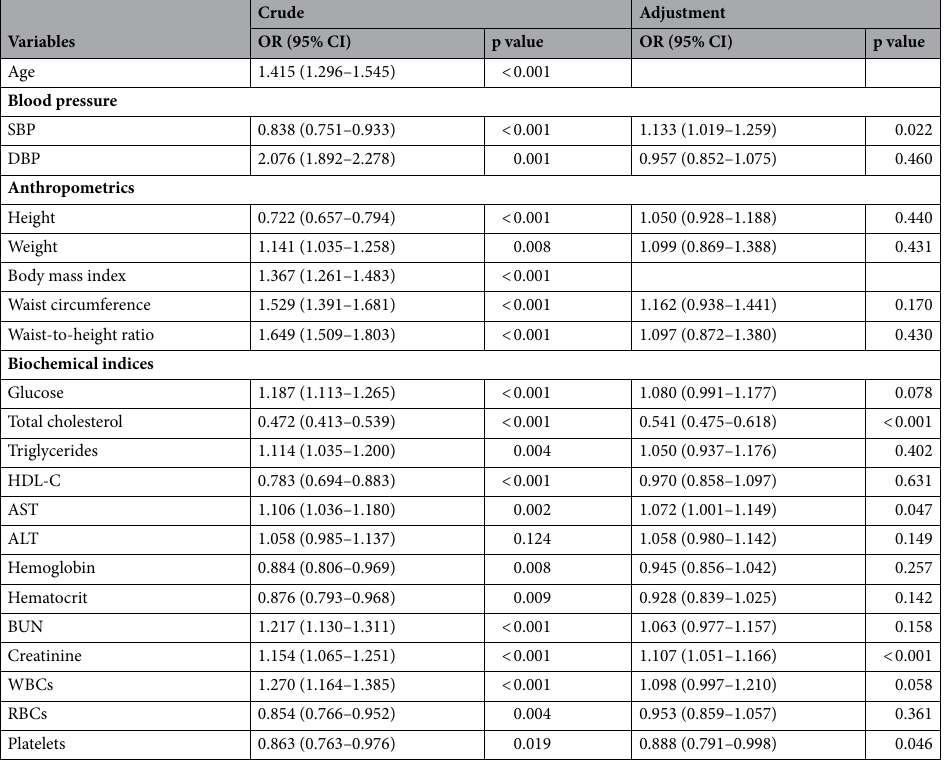
Table 3. Associations of MIAP with blood pressure, anthropometric indices, and biochemical indices in women . OR and p values were obtained from the crude and adjusted analyses using complex sample binary logistic regression. Age, residential area, education, occupation, household income, stress, alcohol consumption, smoking status, family history of IHD, and BMI were used as adjustment variables. Odds ratios were estimated with 95% confidence intervals. MIAP myocardial infarction or angina pectoris, IHD ischemic heart disease, SBP systolic blood pressure, DBP diastolic blood pressure, HDL-C high-density lipoprotein cholesterol, AST aspartate aminotransferase, ALT alanine aminotransferase, BUN blood urea nitrogen, WBC white blood cell, RBC red blood cell, OR odds